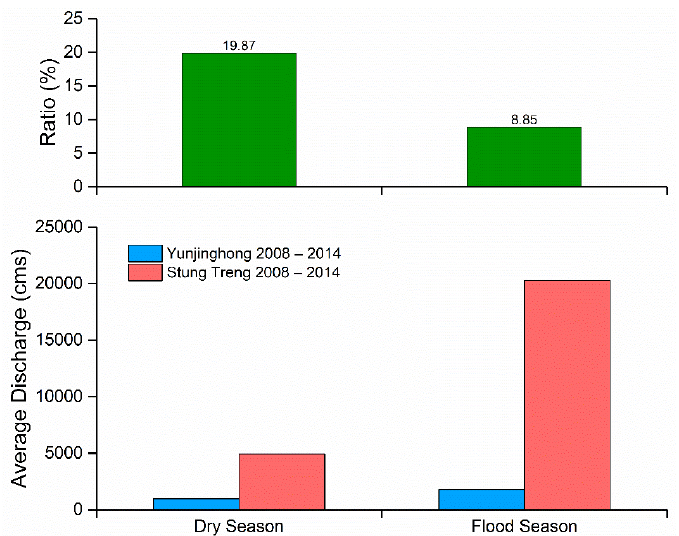
Figure 12. Ratio of Monthly Runoff Measured at the Yunjinghong station to that Measured at the Stung Treng Hydrological Station (Upper Part); Comparison of the Monthly Average Runoff between the Yunjinghong and Stung Treng Hydrological Stations (Lower Part).